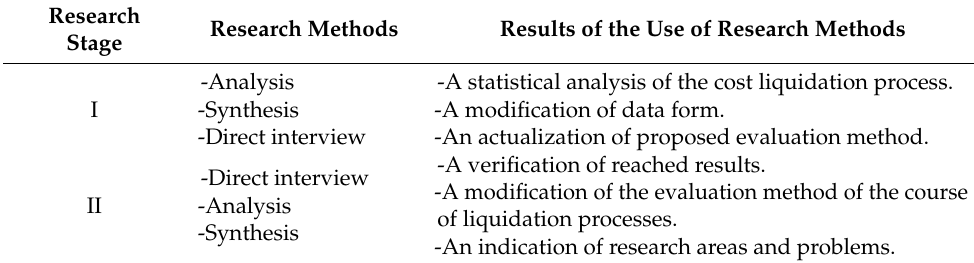
Table 1. Research methods and the results of their use in particular stages of